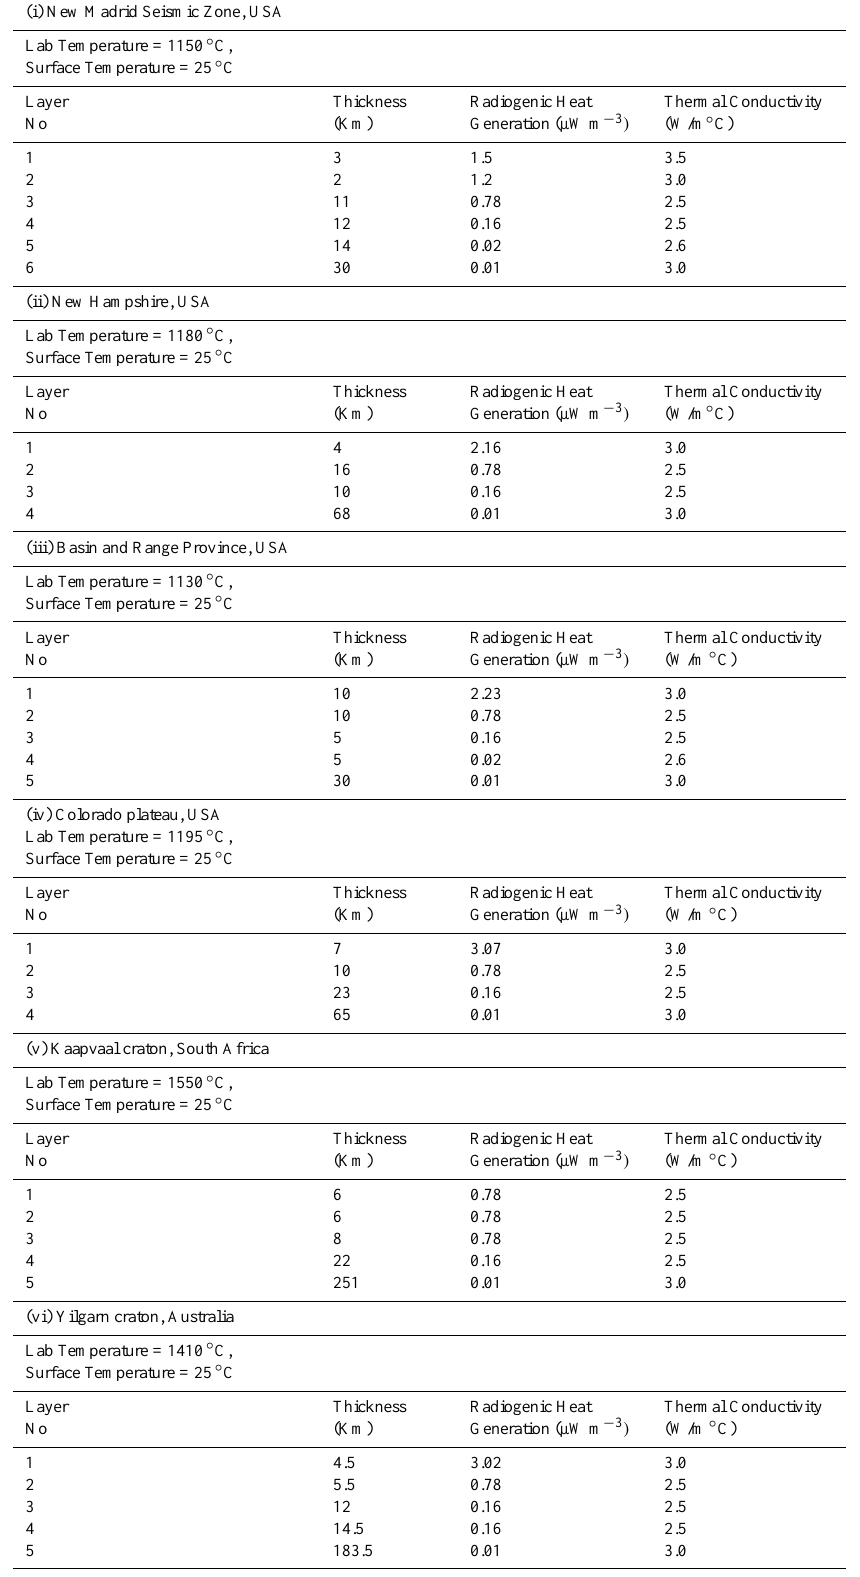
Table 1. Thickness of lithospheric layers and relevant thermal parameters of different geotectonic units used in the prediction of heat flow using inverse recurrence